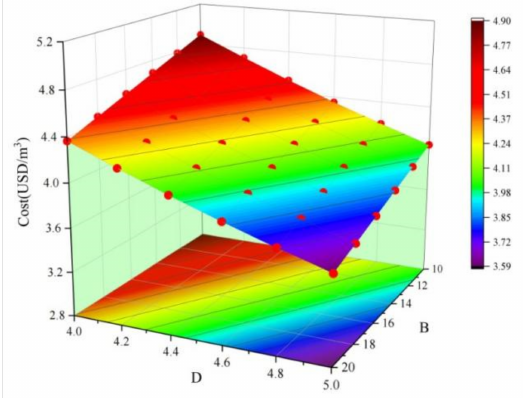
Figure 7. The effect of BD interactions for